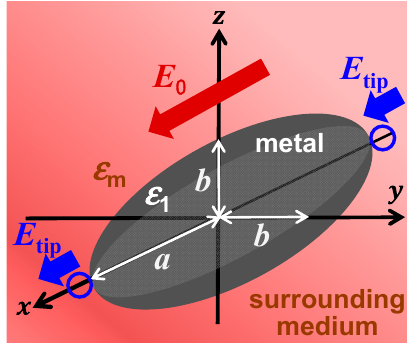
Figure 1. Schematic bird’s-eye view of the system considered in this study for the calculations of field enhancement factors.